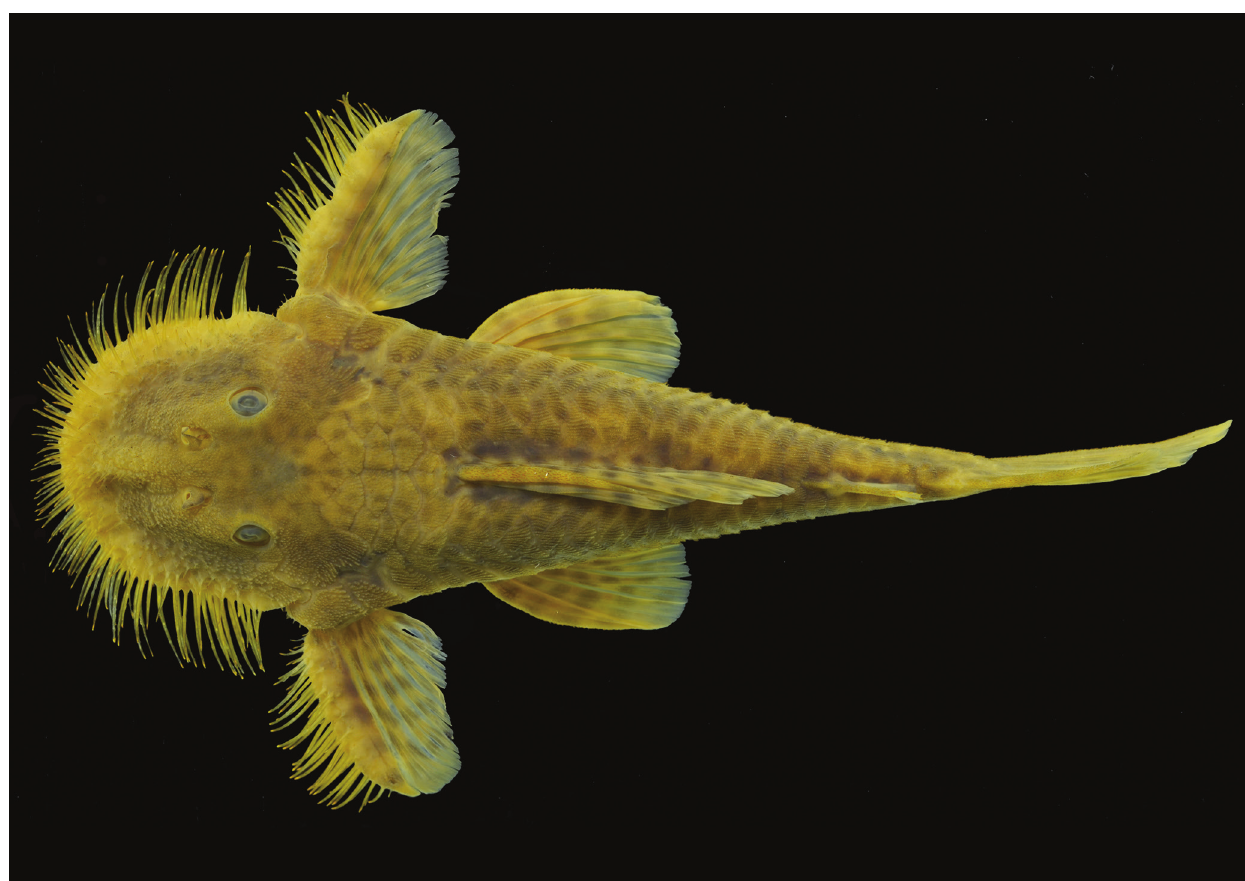
Fig. 5 . Pareiorhaphis stephanus , MCNIP 1696, 91.8 mm SL, Brazil, Minas Gerais State, Cristália, rio Itacambiruçu.